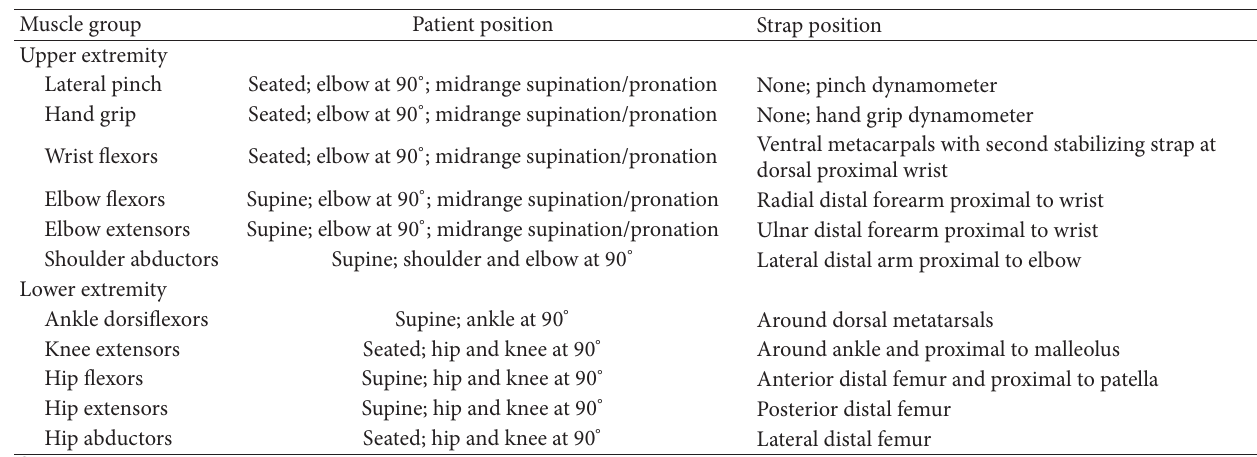
Table7:Quantitativeassessmentofpeakmuscleforce.Thetestedmusclegroups,subjecttestingposition,andorientationofthedynamometer strap are listed for the quantitative assessment of maximum isometric forceC using a fixed dynamometry load cell £